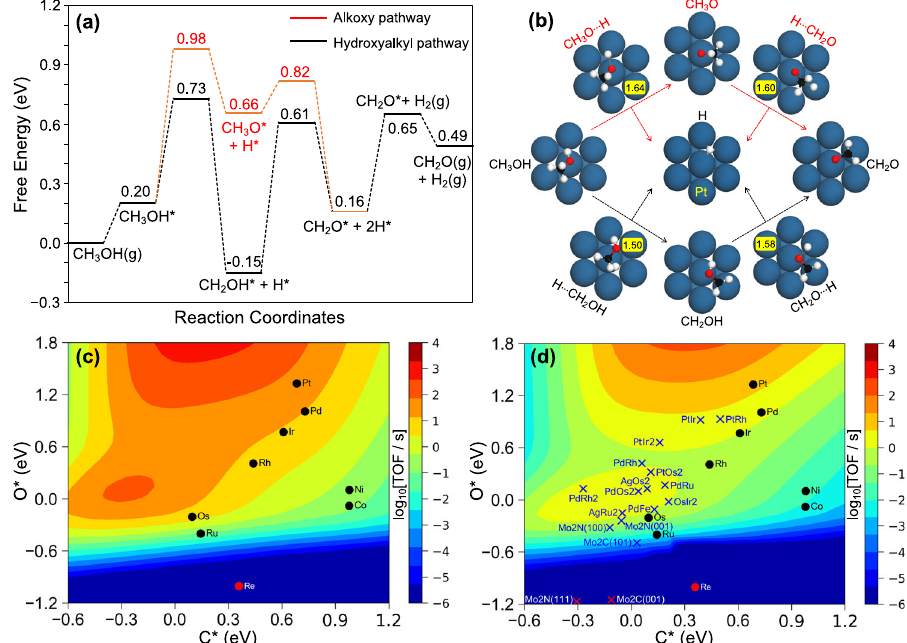
Fig. 1 DFT calculations exploring methanol dehydrogenation into formaldehyde. Free energy pro fi le a and structures of related intermediates and transition states b for CH 3 OH dehydrogenation on Pt(111) via the hydroxyalkyl path (in black) and the alkoxy path (in red) using molecular CH 3 OH and the pristine surface as energy reference at 453 K; c Turnover frequencies (TOFs) of CH 2 O production from CH 3 OH as a function of the C and O adsorption energies (referred to CH 3 OH, H 2 O and H 2 ) at 453 K with p CH3OH = 101 kPa (0.1% conversion), and d turnover frequencies (TOFs) of 2-octanone production from 2-octanol at p OL = 101 kPa (15% conversion). (C in black, O in red, H in white, Pt in blue, numbers in the yellow box provide the length (Å) of bond being broken in